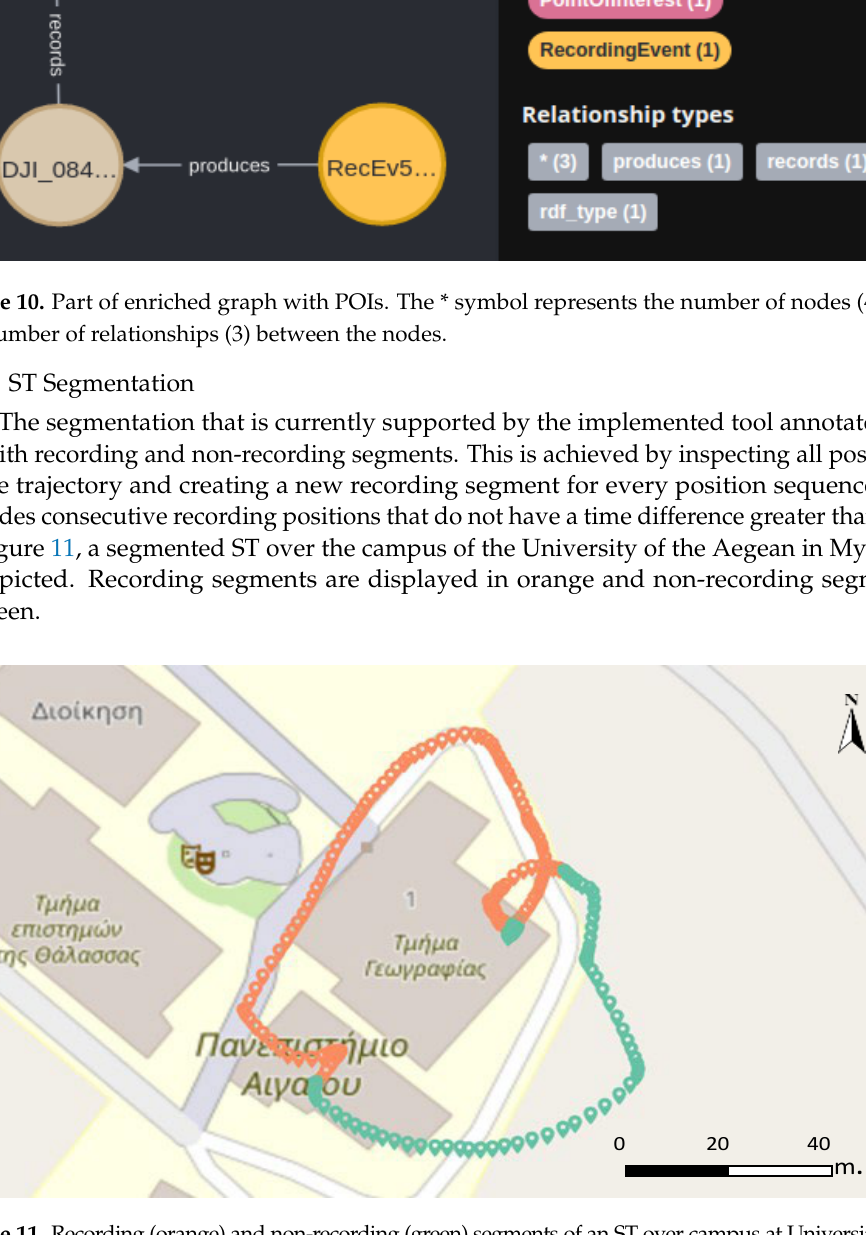
Figure 11. Recording (orange) and non-recording (green) segments of an ST over campus at Univer- sity Hill.